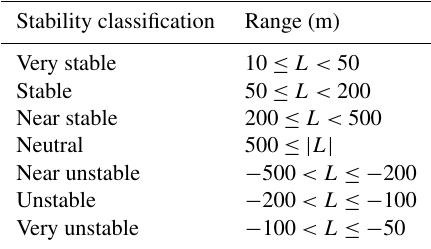
Table 3. Stability classification based on the Obukhov length, L (m), derived from Eq.